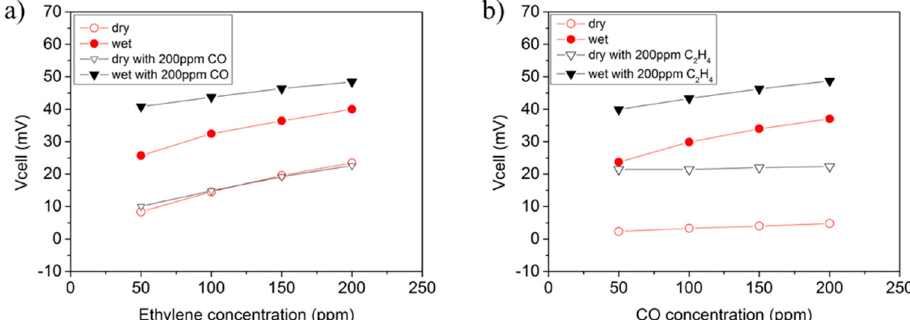
Figure 6. EMF Sensor response as a function of analyte concentration for: ( a ) C 2 H 4 and ( b ) CO. The effect of a background concentration (200 ppm) of the second analyte and 3% of water is also depicted. Each point is the main of the respective 20 min change in response. Table 1. Sensitivity of the sensor to C 2 H 4 , carbon monoxide, and each analyte with 200 ppm of background of the second analyte for dry and wet (3%) conditions, as well as for 0.16 ppm of C 14 H 10 . Sensor sensitivity is defined as V cell /analyte concentration (mV/ppm) and calculated as a linear regression. Analyte